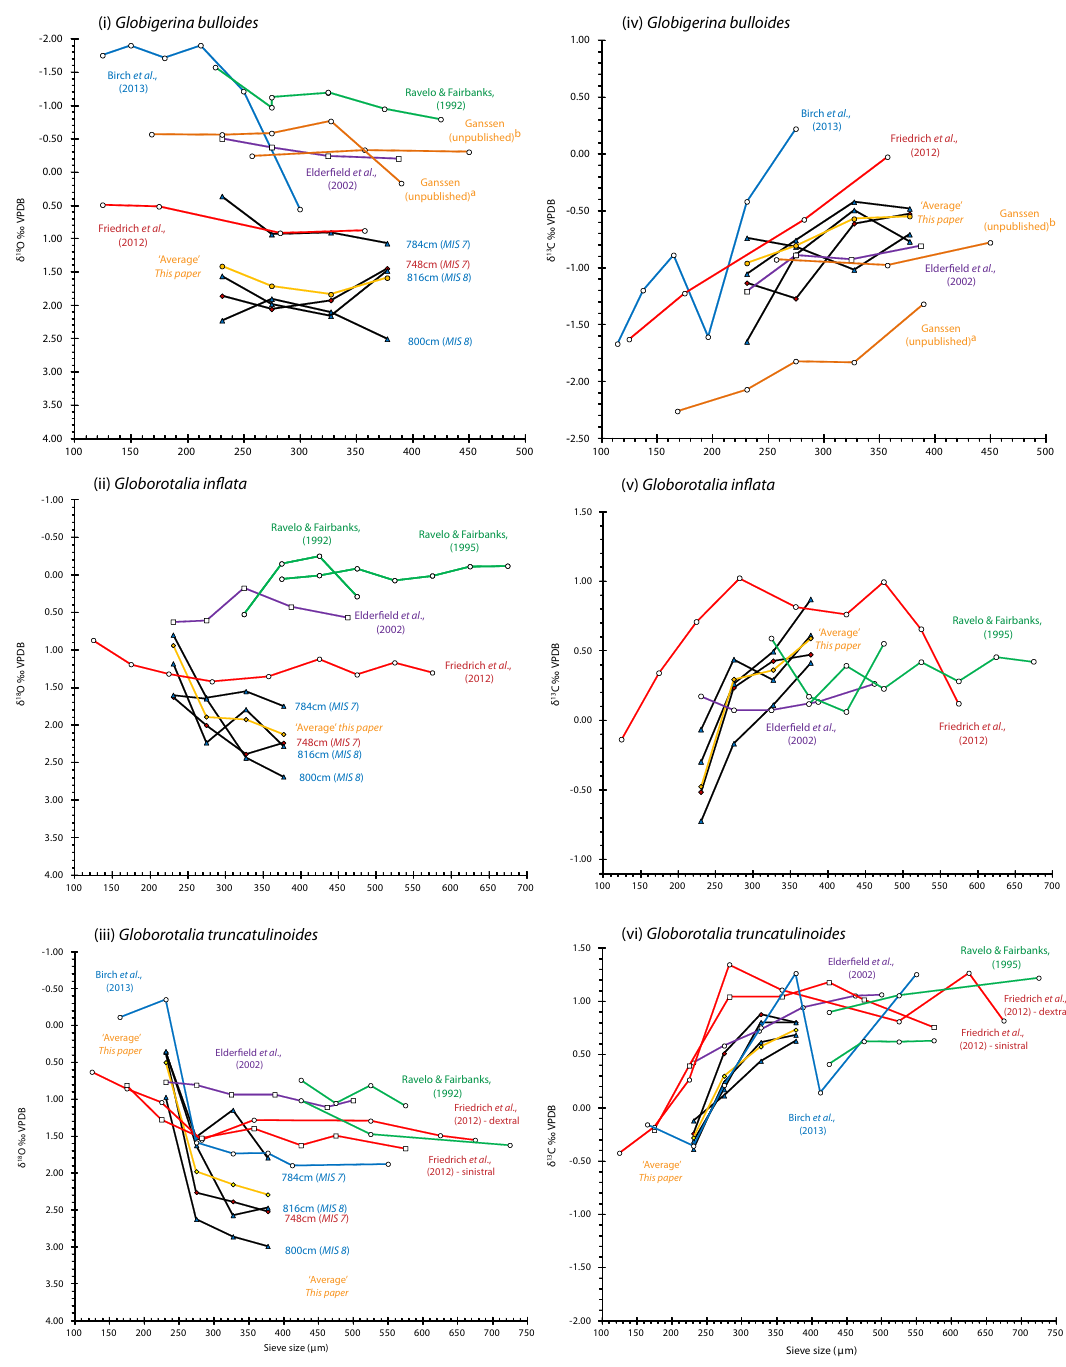
Figure 10. Previous size–isotope relationship. Previously published size–isotope trends (i–iii) δ 18 O and (iv–vi) δ 13 C compared with four samples that represent, based upon the ratio between Neogloboquadrina pachyderma and N. incompta (unpublished data), cold and warm periods of MIS 8 and MIS 7. Additionally, an average size–isotope curve was constructed for comparison. Unpublished work of Ganssen from Indian Ocean core